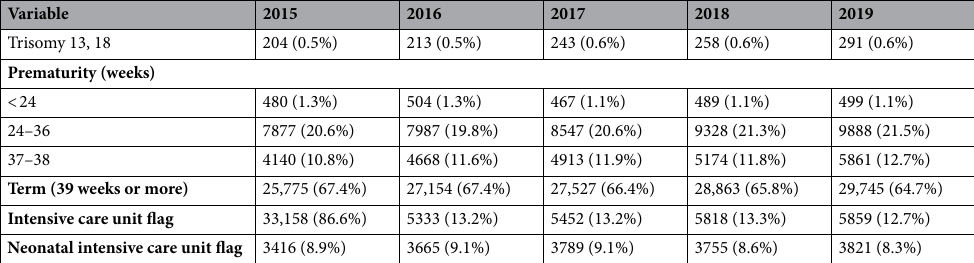
Table 1. Demographics and patient characteristics of patients with congenital heart disease undergoing non- cardiac surgery. Insurance : government includes: in-state and out-of-state medicaid, medicare, TRICARE, CHIP and other government. Intensive care unit (ICU) flag and neonatal intensive care unit (NICU) flag: patient had an ICU or NICU stay during their hospital encounter. a Other payor, self-pay, charity, and unknown.